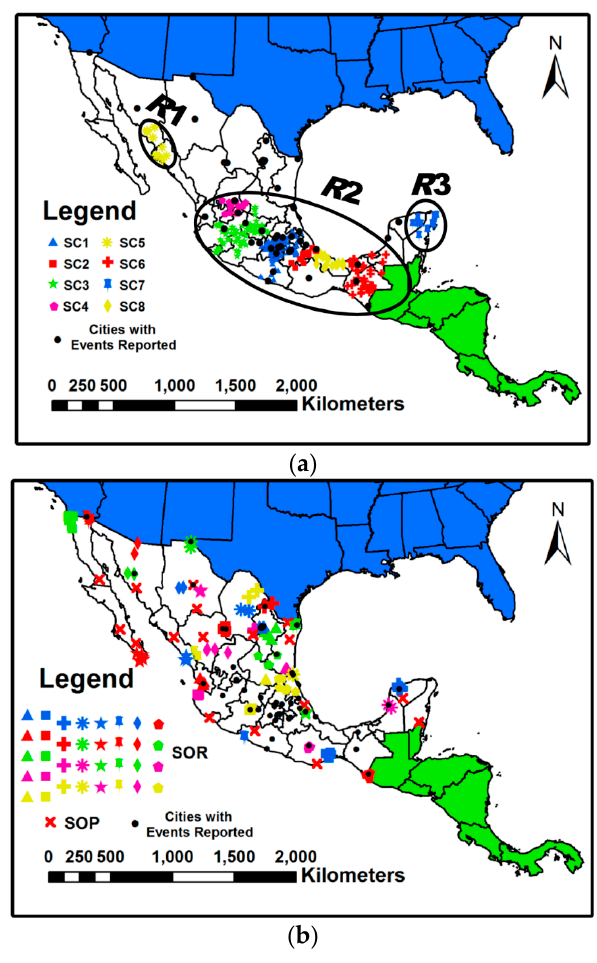
Figure 10. The spatial distribution patterns for STE . ( a ) spatial clusters; ( b ) spatial outliers. SOP and SOR represent spatial outlier points and regions respectively.